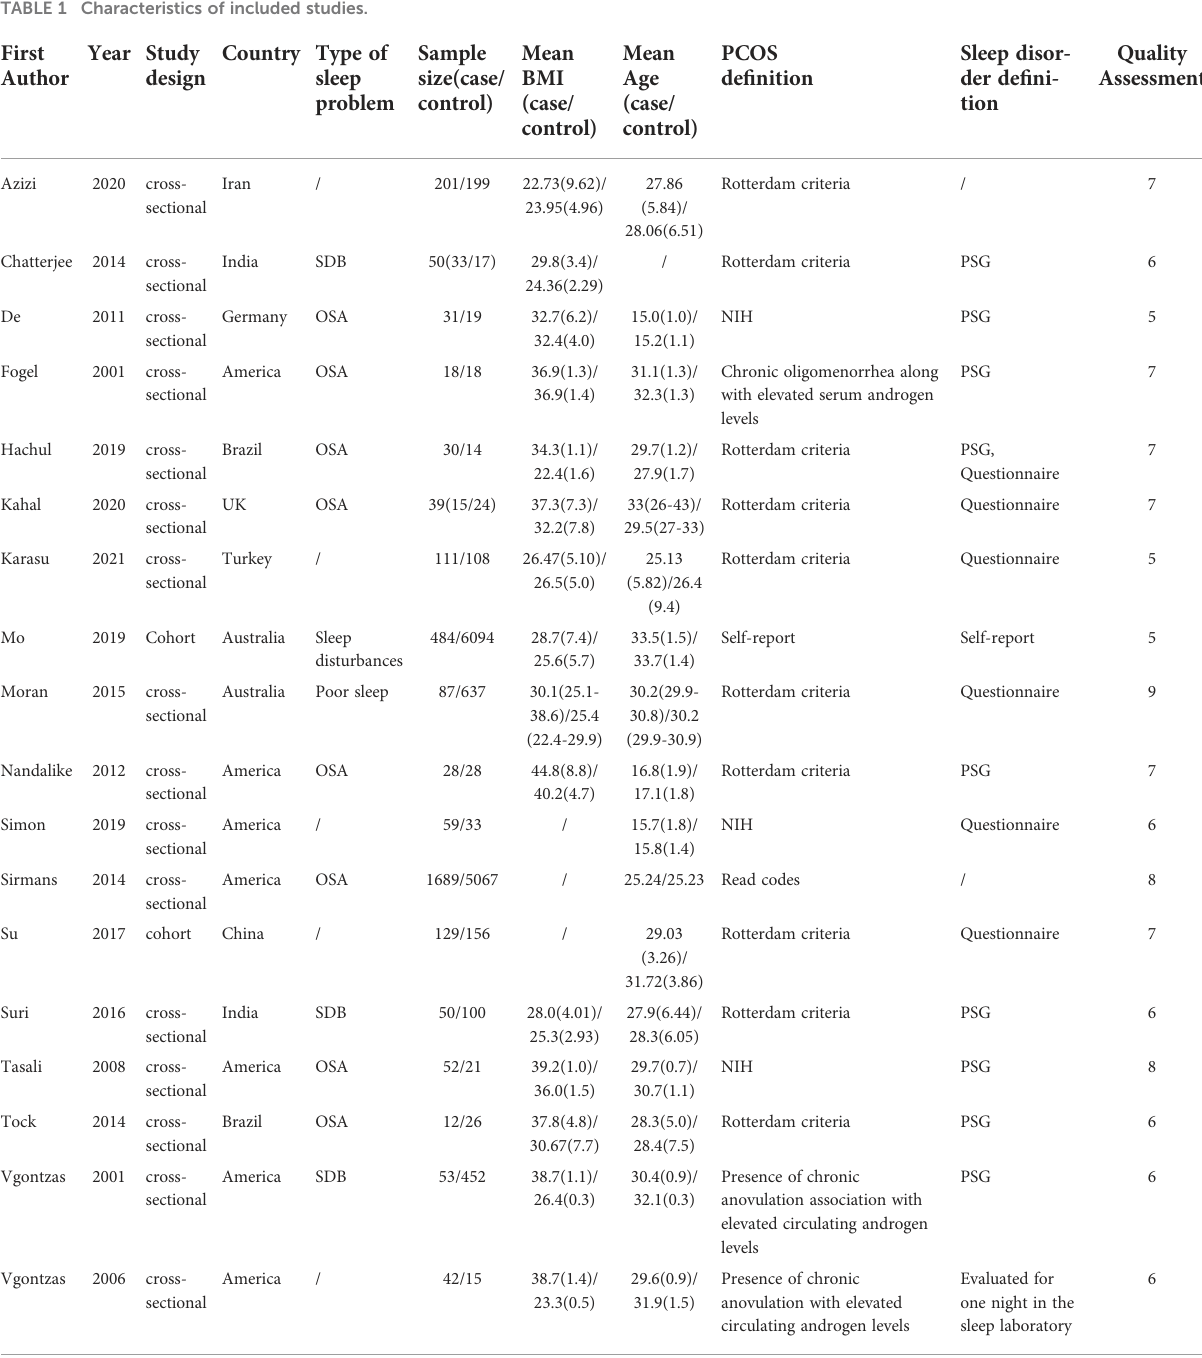
TABLE 1 Characteristics of included